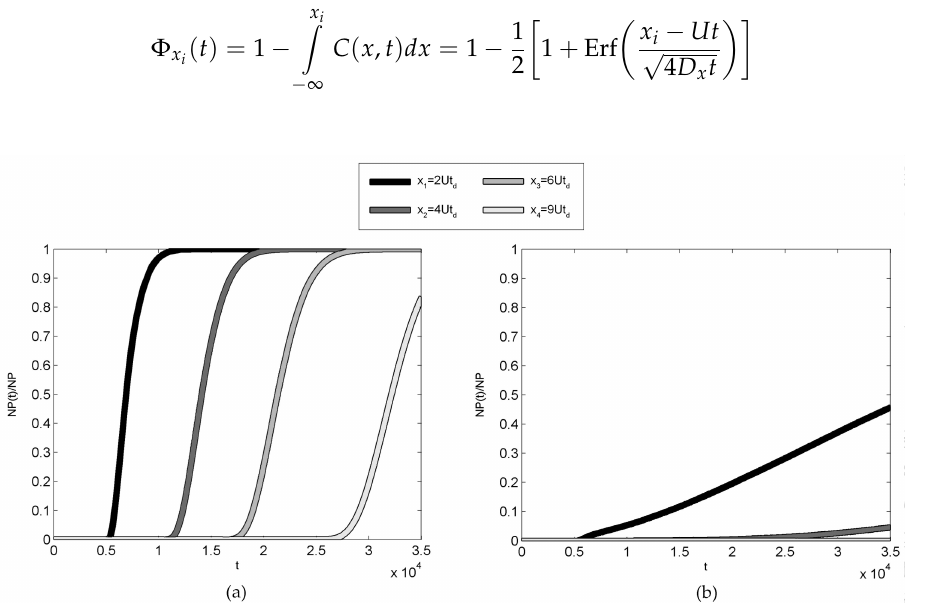
Figure 4. Breakthrough curves for R1. ( a ) Uniform mixing; ( b ) Non-uniform mixing.